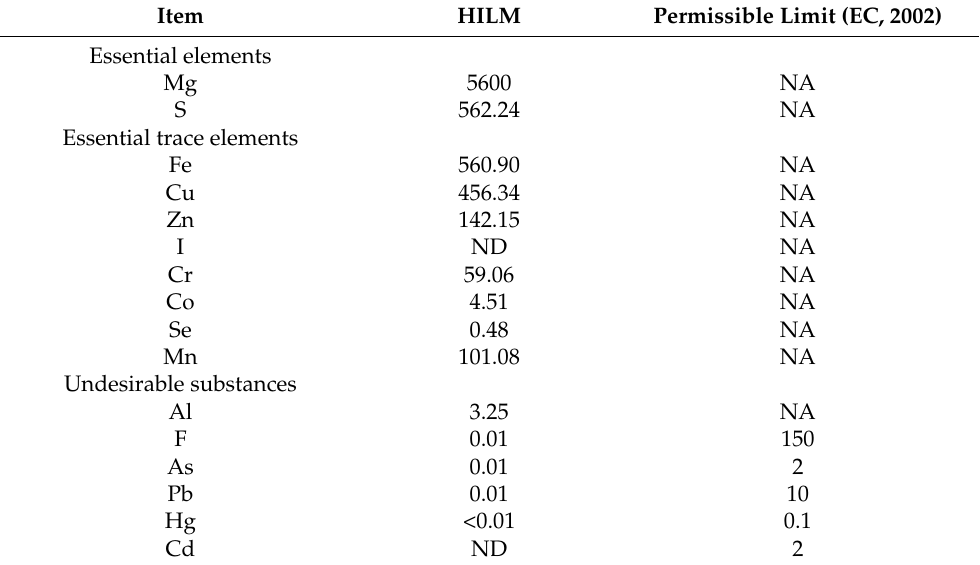
Table 7. Essential elements and undesirable substances (mg/kg) in Hermetia illucens larvae meal (HILM).